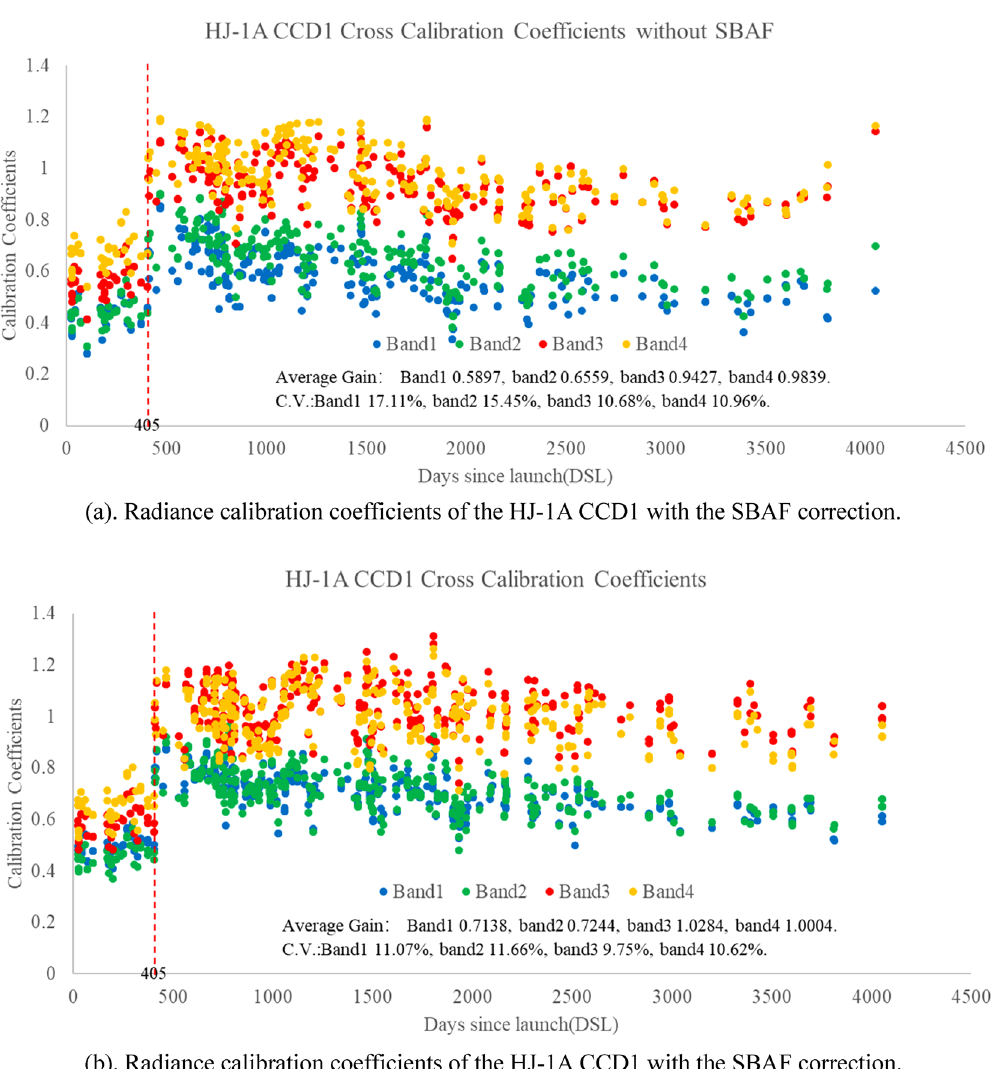
Figure 8. Radiance calibration coefficients of the HJ-1A CCD1 with and without the SBAF